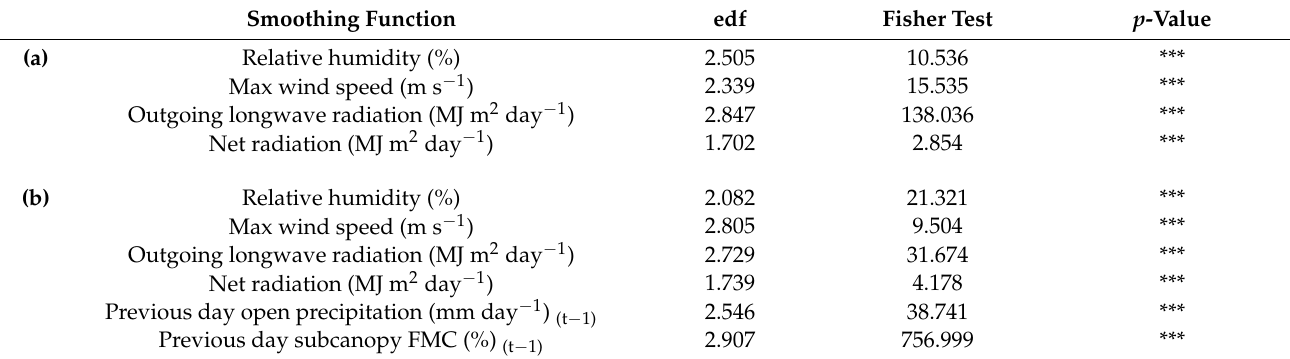
Table 5. Diagnostics of the GAMMs developed with (a) independent (weather-only) data and (b) autoregressive data which included lagged variables at the site